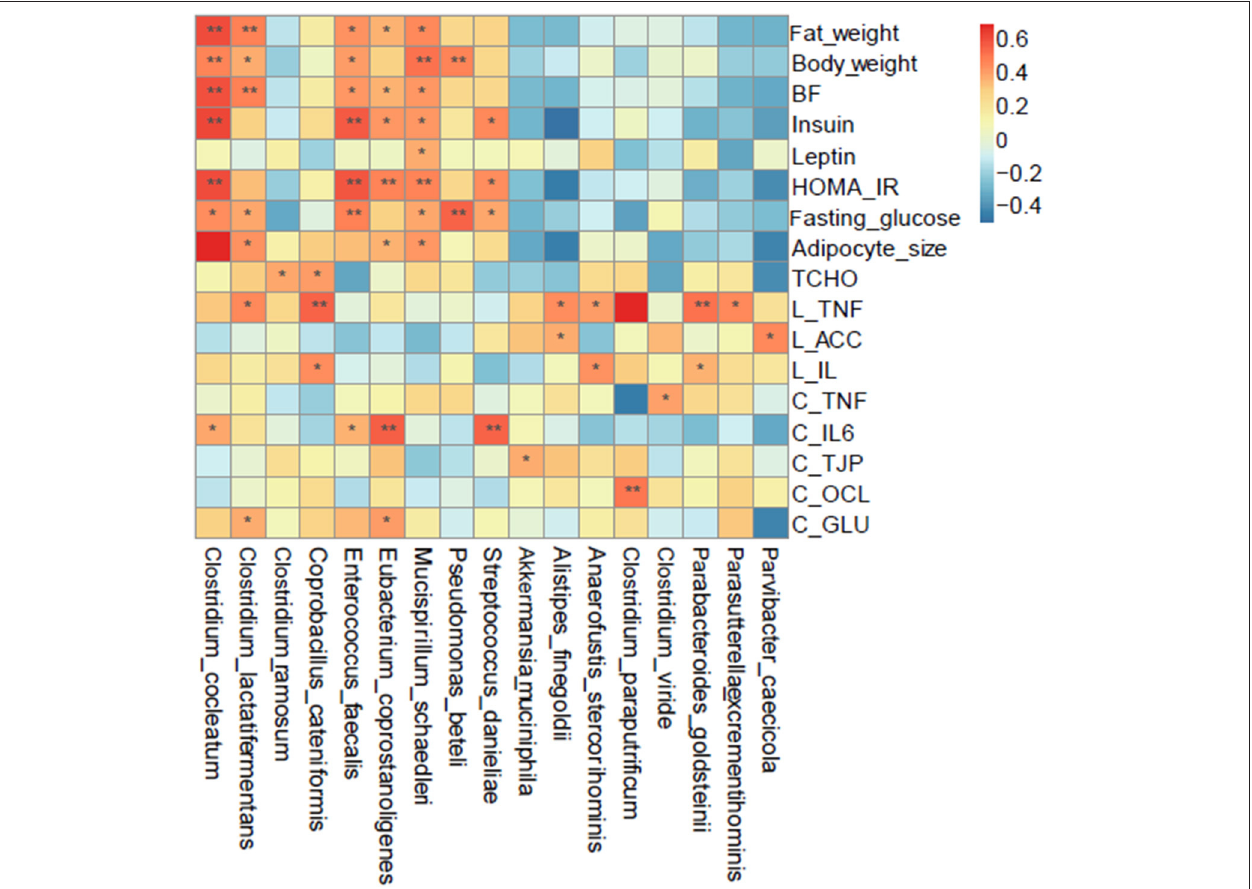
FIGURE 6 | Spearman correlation analysis of the bacteria at the species level and metabolic syndrome-related indices. Groups: Group L (low-fat diet group, fed with 4.3% fat, 5% cellulose); LC group (low-fat diet + COS group, fed with 4.3% fat, 5% COS); group H (high-fat diet group, fed with 35.4% fat, 5% cellulose); and HC group (high Fat diet + COS group, fed with 35.4% fat, 5%